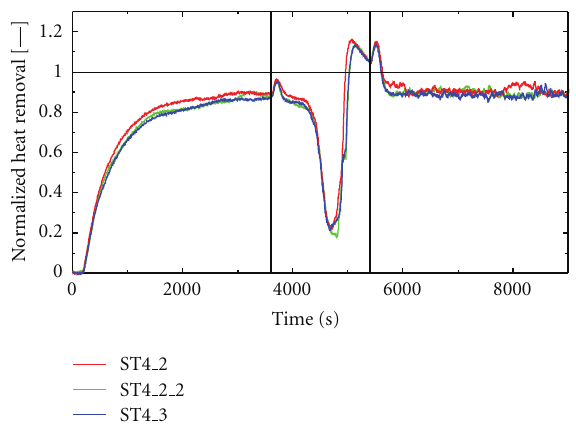
Figure 21: Suggested flow pattern during the cooler performance deterioration configuration.